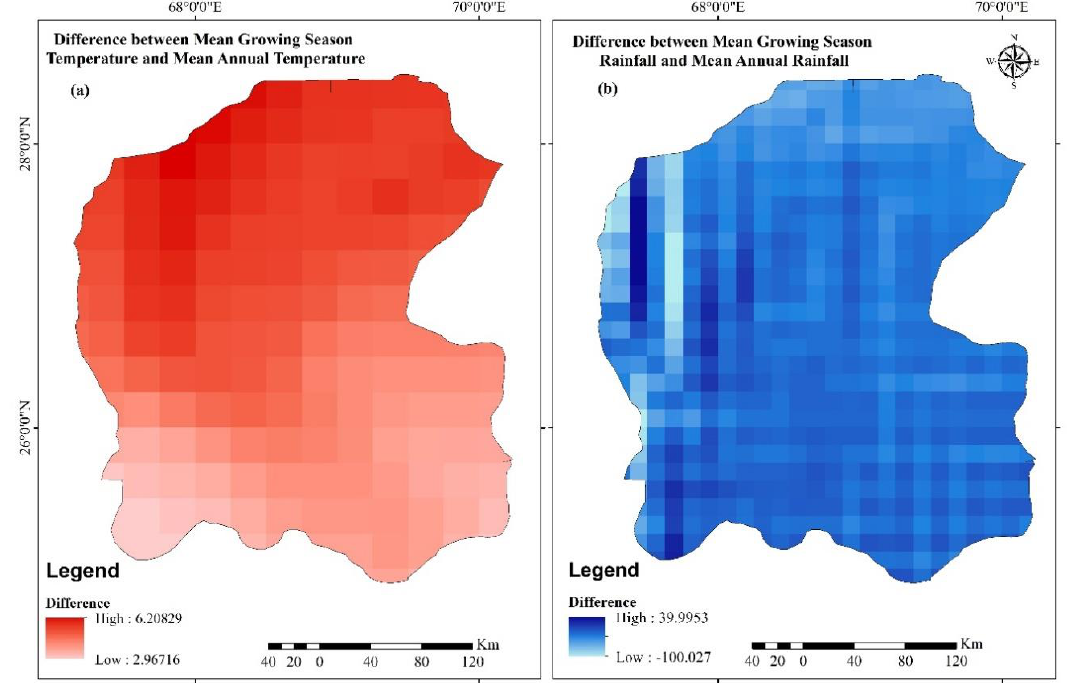
Figure 3. ( a ) Di ff erence between mean Growing Season Temperature and Mean Annual Temperature; Figure 3. ( a ) Difference between mean Growing Season Temperature and Mean Annual Temperature; ( b ) Di ff erence between mean Growing season Rainfall and Mean Annual ( b ) Difference between mean Growing season Rainfall and Mean Annual Rainfall.